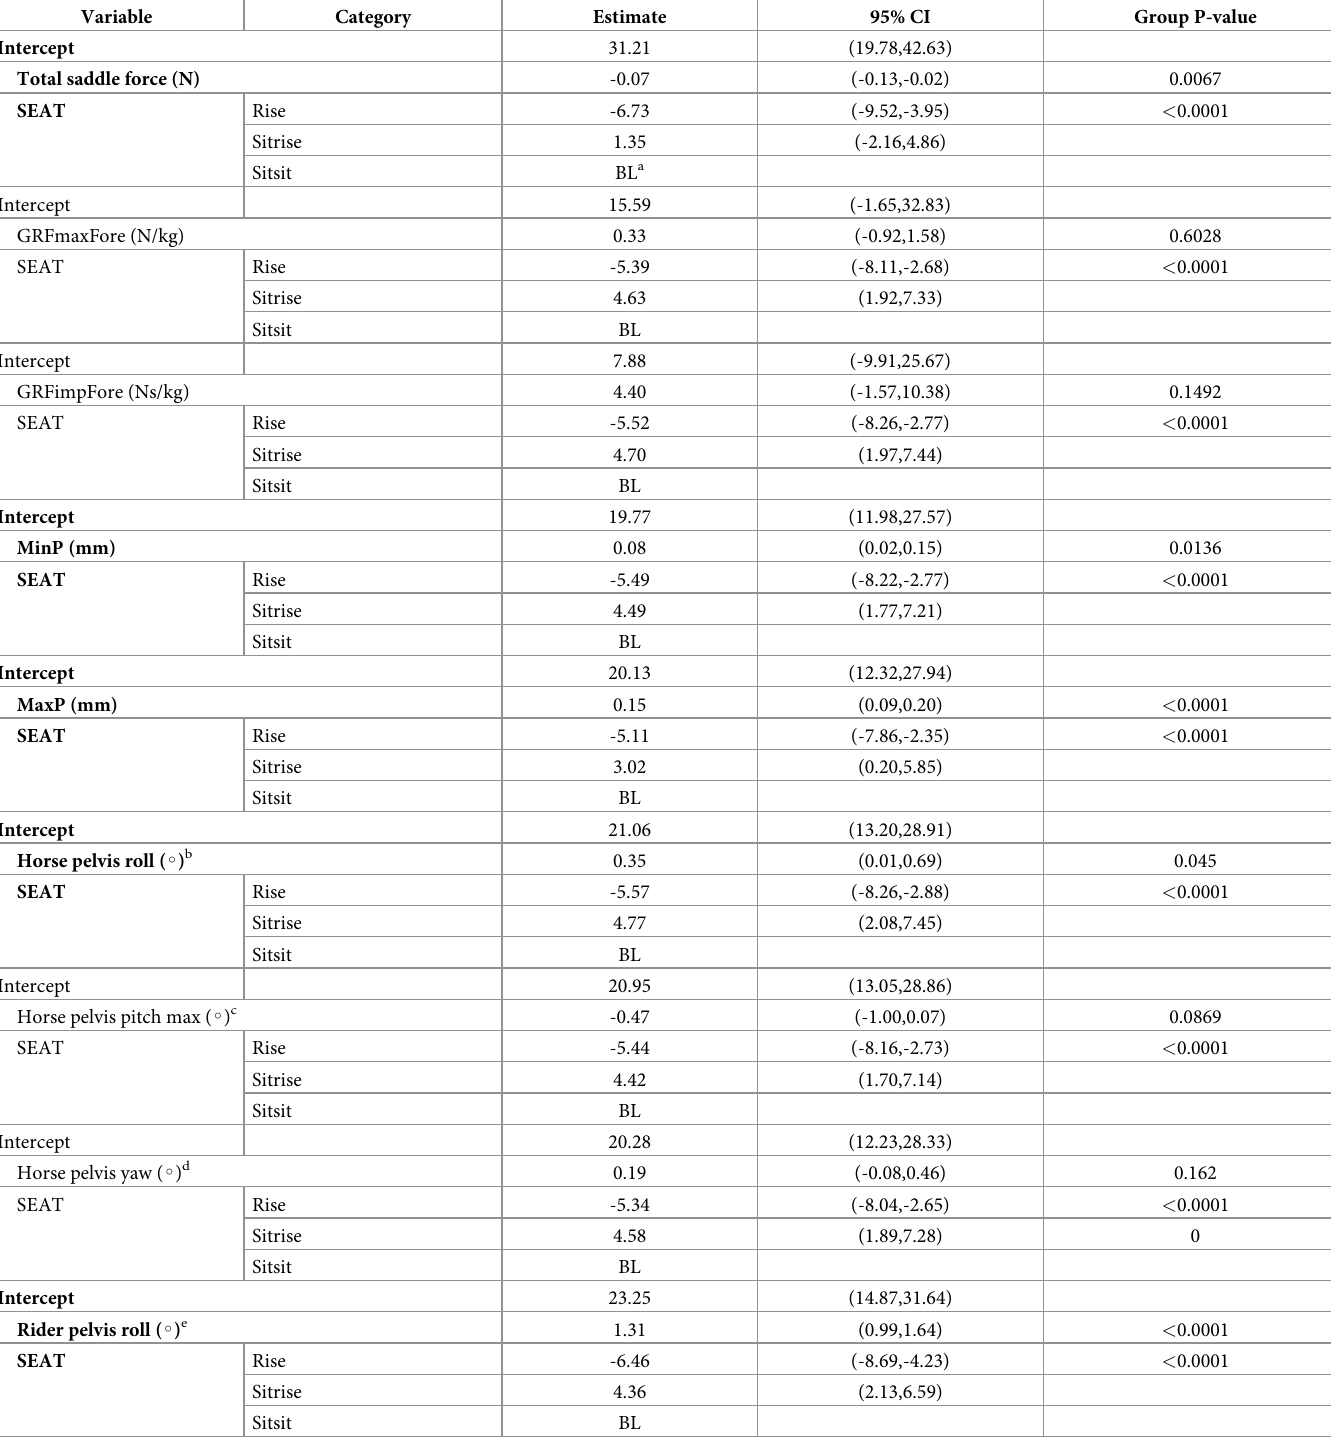
Table 2. Preliminary bi-variable mixed models with p-values < 0.20. Rising and sitting trot data (620 diagonal steps, 21 trials, 7 horses except for in the two bottom models which are 590 steps, 20 trials, 7 horses) with the outcome variable, lateral movement of the saddle in relation to the horse spine, in mm. Bolded variables were entered into the full model for further reduction. Estimates and their 95% confidence intervals (95% CIs) are provided. Group P-values are used to evaluate significance of a variable as a whole (e.g.